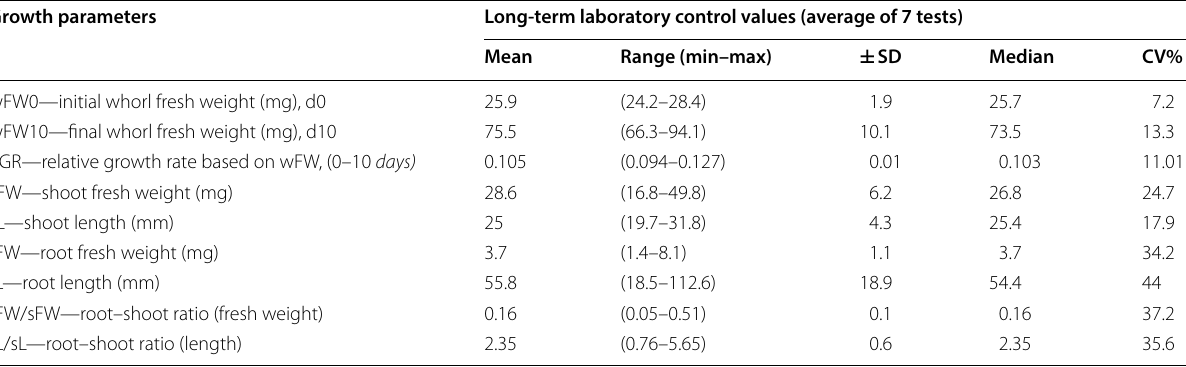
Standard growth parameter according to ISO 16191 [22]